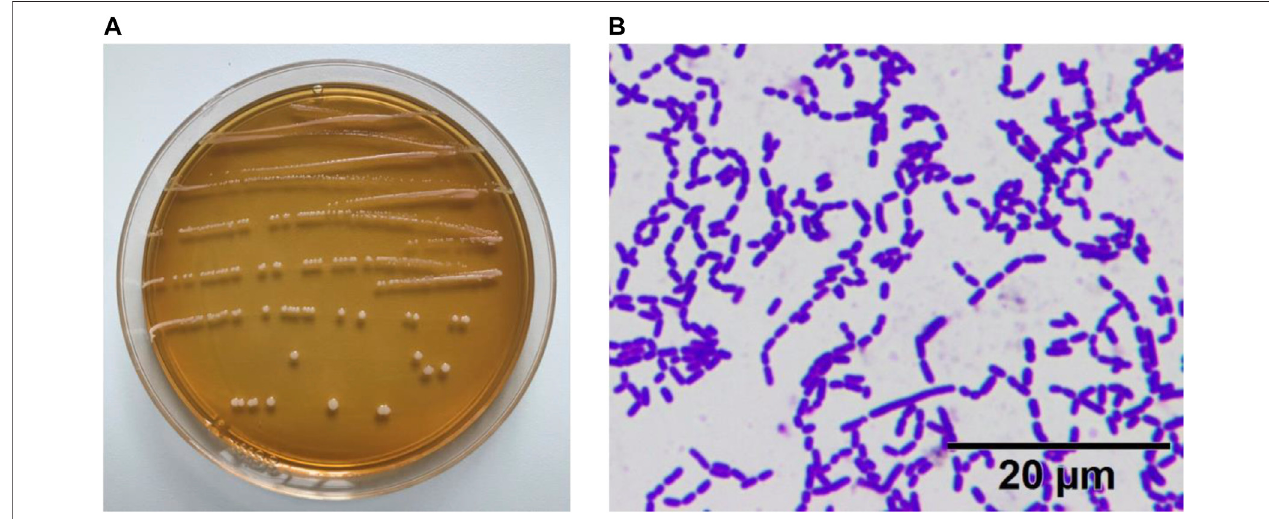
FIGURE 1 | Morphological characteristics of experimental lactic acid bacterium ZS40. (A) colonies of the experimental strain. (B) Gram staining.